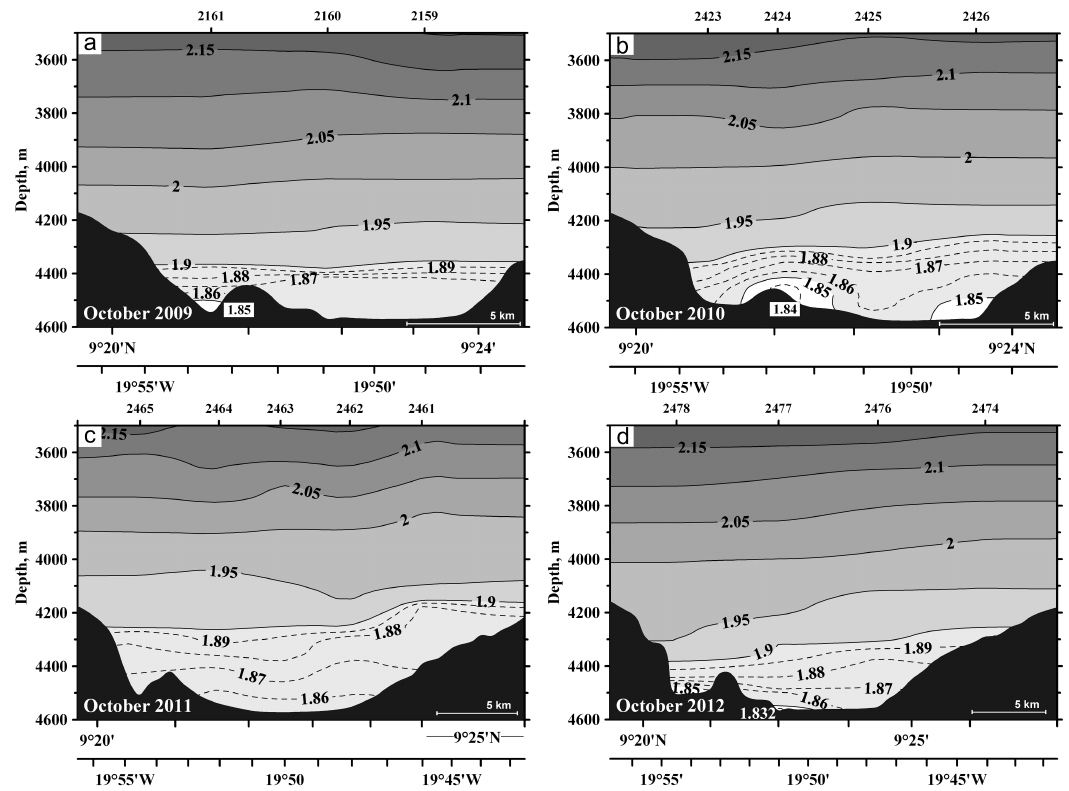
Fig. 6. Sections of potential temperature ( ◦ C), across the Kane Gap in October 2009 (a) , October 2010 (b) , October 2011 (c) , and October 2012 (d) . Numbers of stations are shown above and coordinates are below. The horizontal scale is shown in the bottom right corner. Figure 6a is adopted with modifications from Morozov et al.